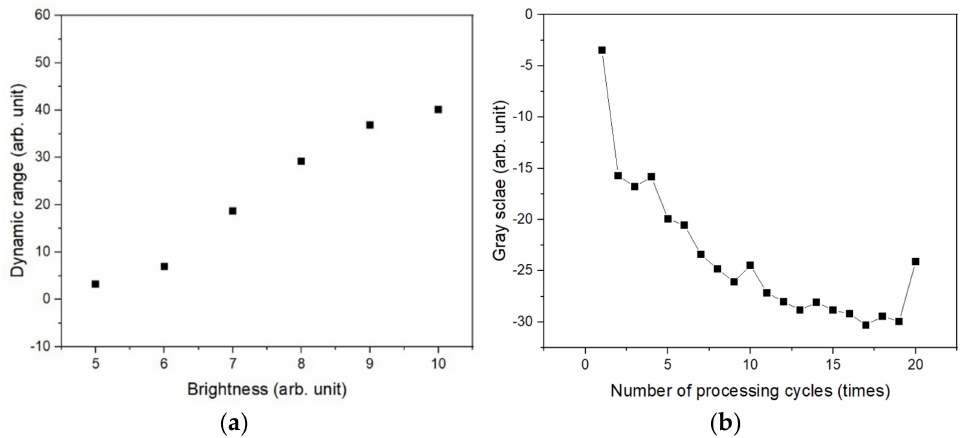
Figure 5. Dynamic range based on light intensity and number of laser treatments: ( a ) change in dynamic range as a function of light brightness; ( b ) gray scale and dynamic range as a function of the number of laser treatments and the hole processed under a laser power of 130